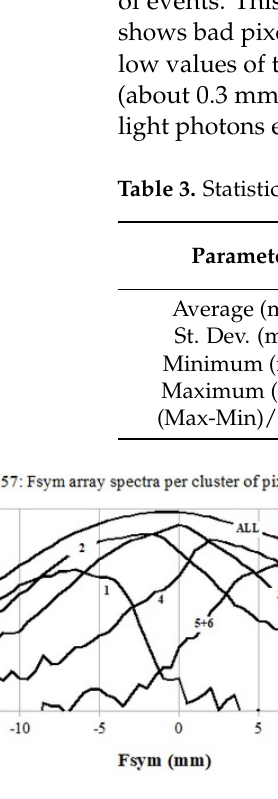
Figure 6. Fsym spectra per cluster of pixels from the Co-57 ( left ) and the Ba-133 ( right ) data. All event spectra of the array are drawn (topmost curves) together with the ones of the individual clusters from 1 to 5 + 6, represented, respectively, from the left to the right. Bin-sizes are of 0.2-, and 0.6-mm, respectively.